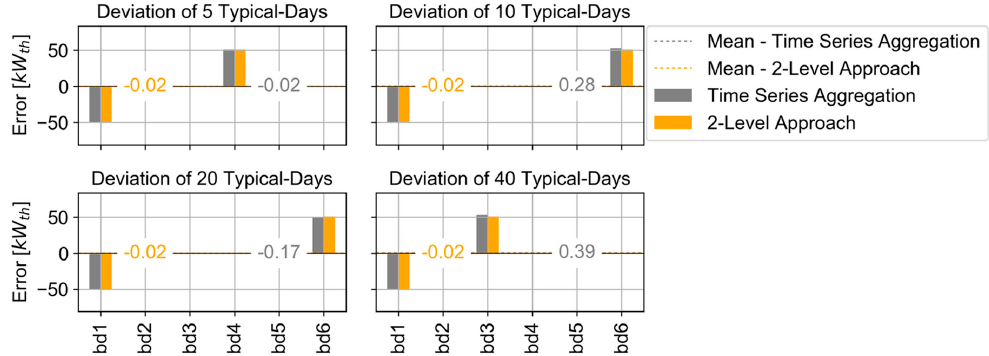
Figure 7. Deviation of installed CHP capacities with 2-Level Approach and time series aggregation in buildings (bd) compared to full time series.